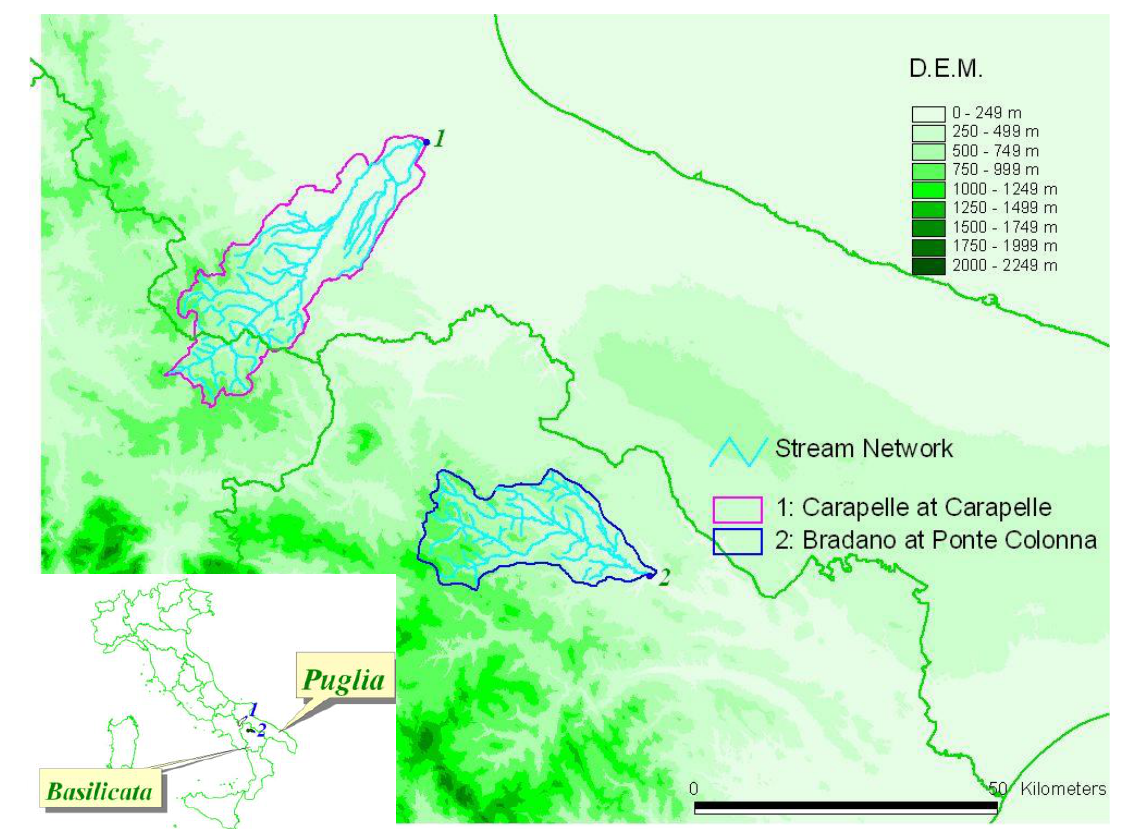
Figure 1. Basins of Southern Italy selected as case studies.